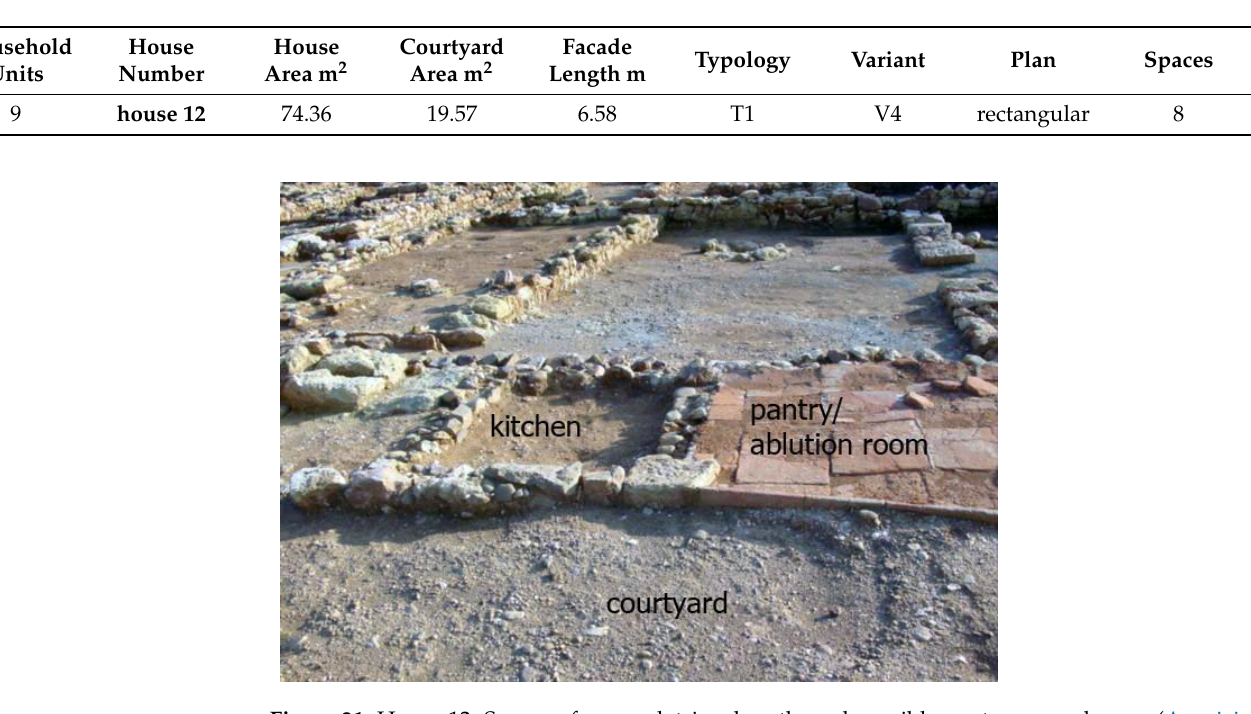
Figure 21. House 12. Spaces of annex: latrine, hearth, and possible pantry or washroom (Aparicio Sánchez 2017, Figure 12).